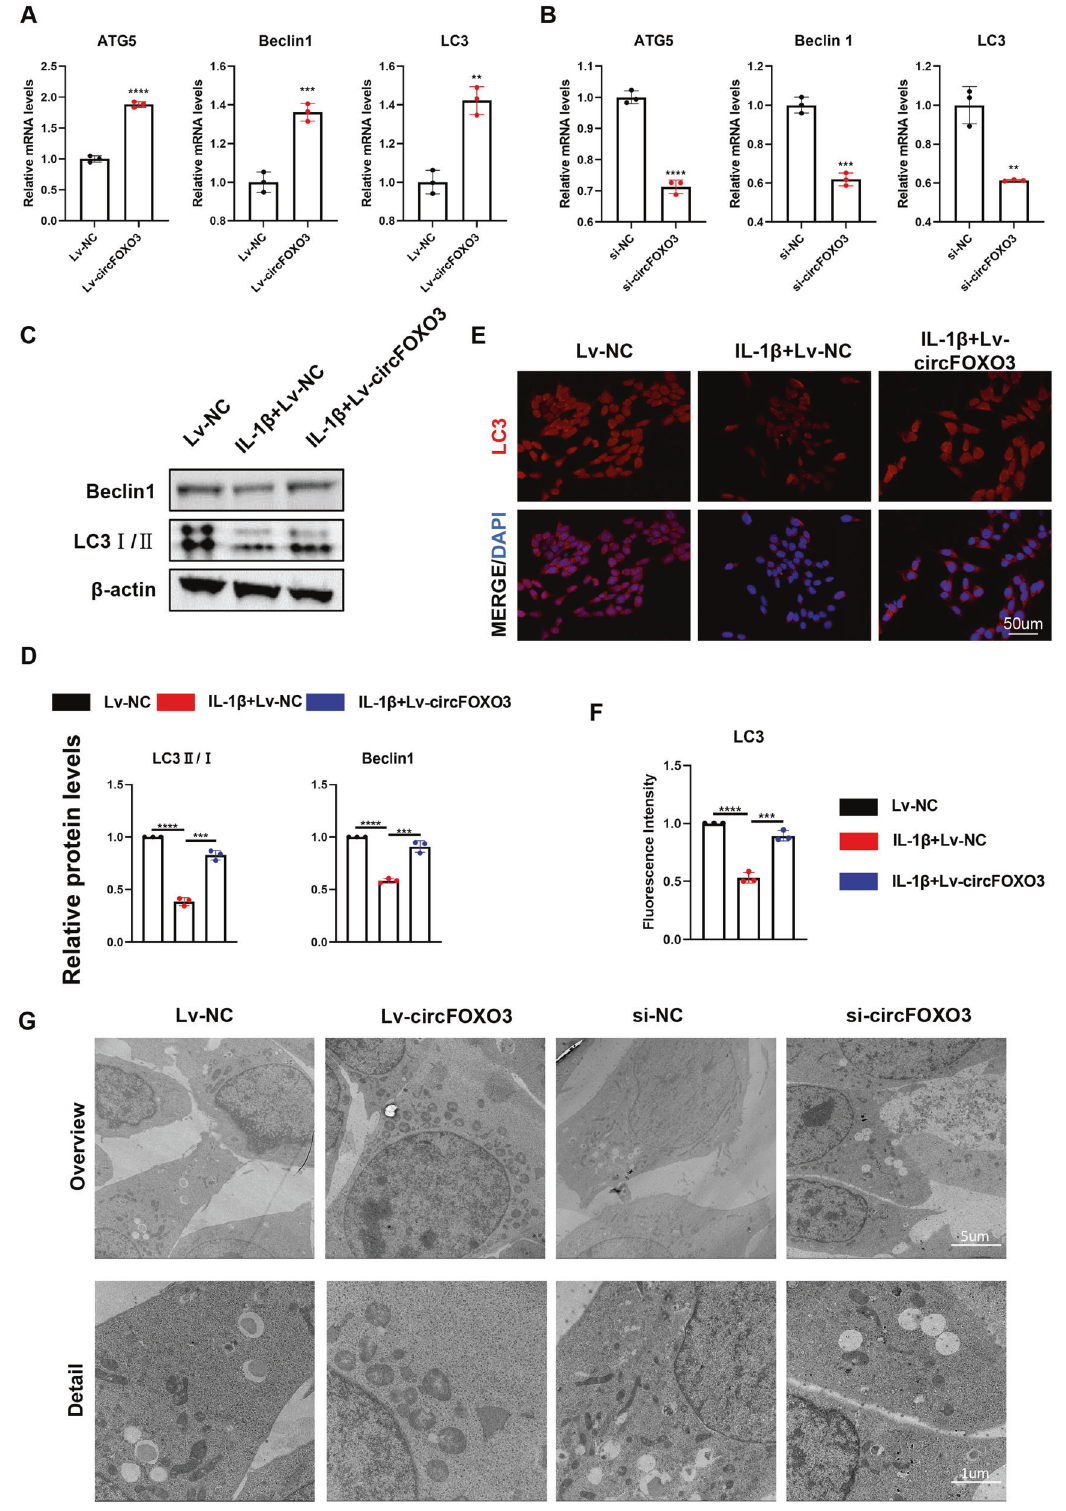
Fig. 5 CircFOXO3 enhances autophagy in IL-1 β -treated ATDC5 chondrocytes. A The expression levels of ATG5, Beclin1 and LC3 was detected by qRT-PCR when circFOXO3 was overexpressed in ATDC5s. ( n = 3) ** p < 0.01, *** p < 0.001, **** p < 0.0001. B The expression levels of ATG5, Beclin1 and LC3 was detected by qRT-PCR when circFOXO3 was downregulated in ATDC5s. ( n = 3) **p < 0.01, *** p < 0.001, **** p < 0.0001. C, D Western blot analysis of LC3 and Beclin1 when circFOXO3 was overexpressed in ATDC5 chondrocytes. The optical density analysis was performed from the results of three independent experiments of western blot samples. *** p < 0.001, **** p < 0.0001. E, F Representative photomicrographs and fl uorescence intensity of IF of LC3 in ATDC5s after treating with IL-1 β (10 ng/ml) for 24 h and the saving effects of overexpressed circFOXO3 on IL-1 β . ( n = 3) Scale bar, 50 µm. *** p < 0.001, **** p < 0.0001. G Representative TEM images of chondrocytes treated with Lv-circFOXO3 or si-circFOXO3. Scale bars, 5 µm and 1 µm. Cell Death and Disease (2022)